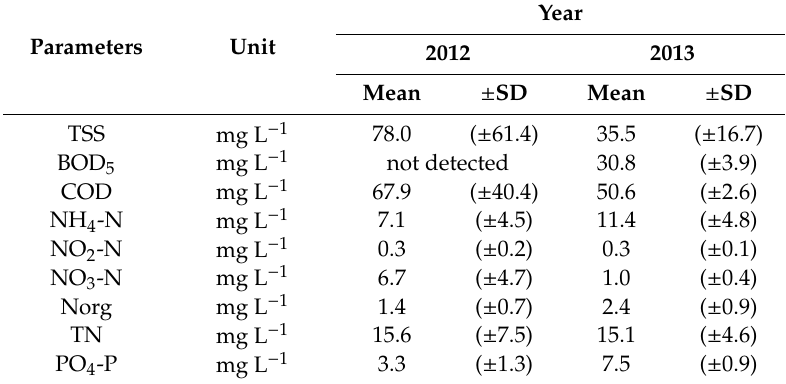
Table 1. Mean influent ( ± SD) pollutant concentrations of all the constructed wetland (CW) beds during 2012 and 2013